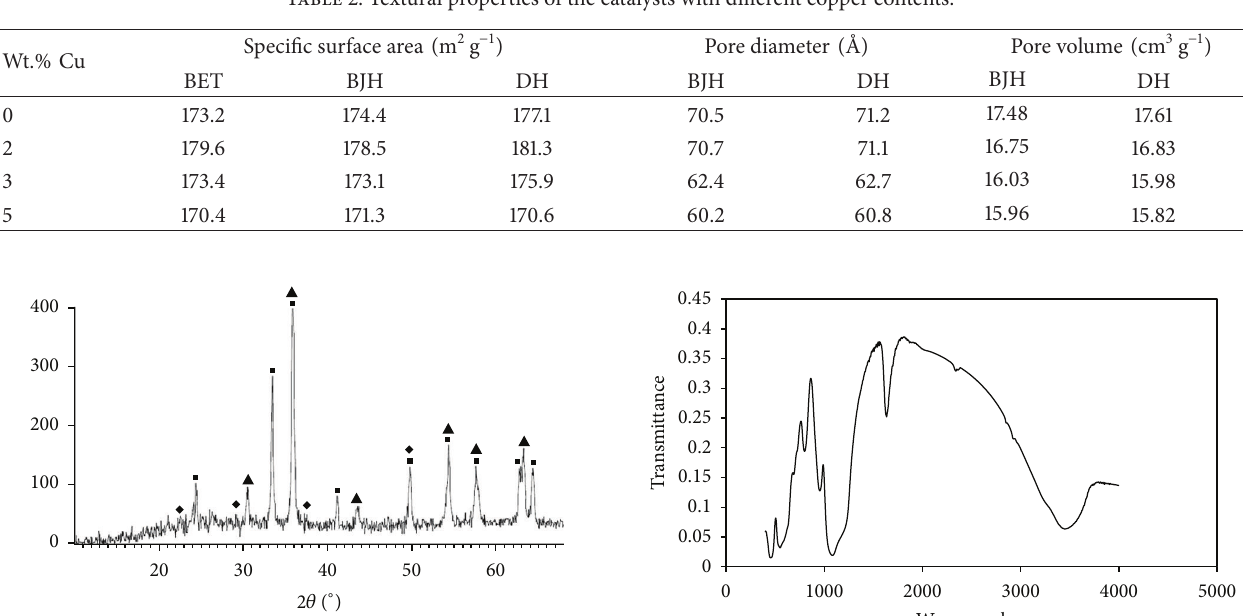
Figure 9: FT-IR spectrum of the Fe-V/SiO 2 promoted with copper